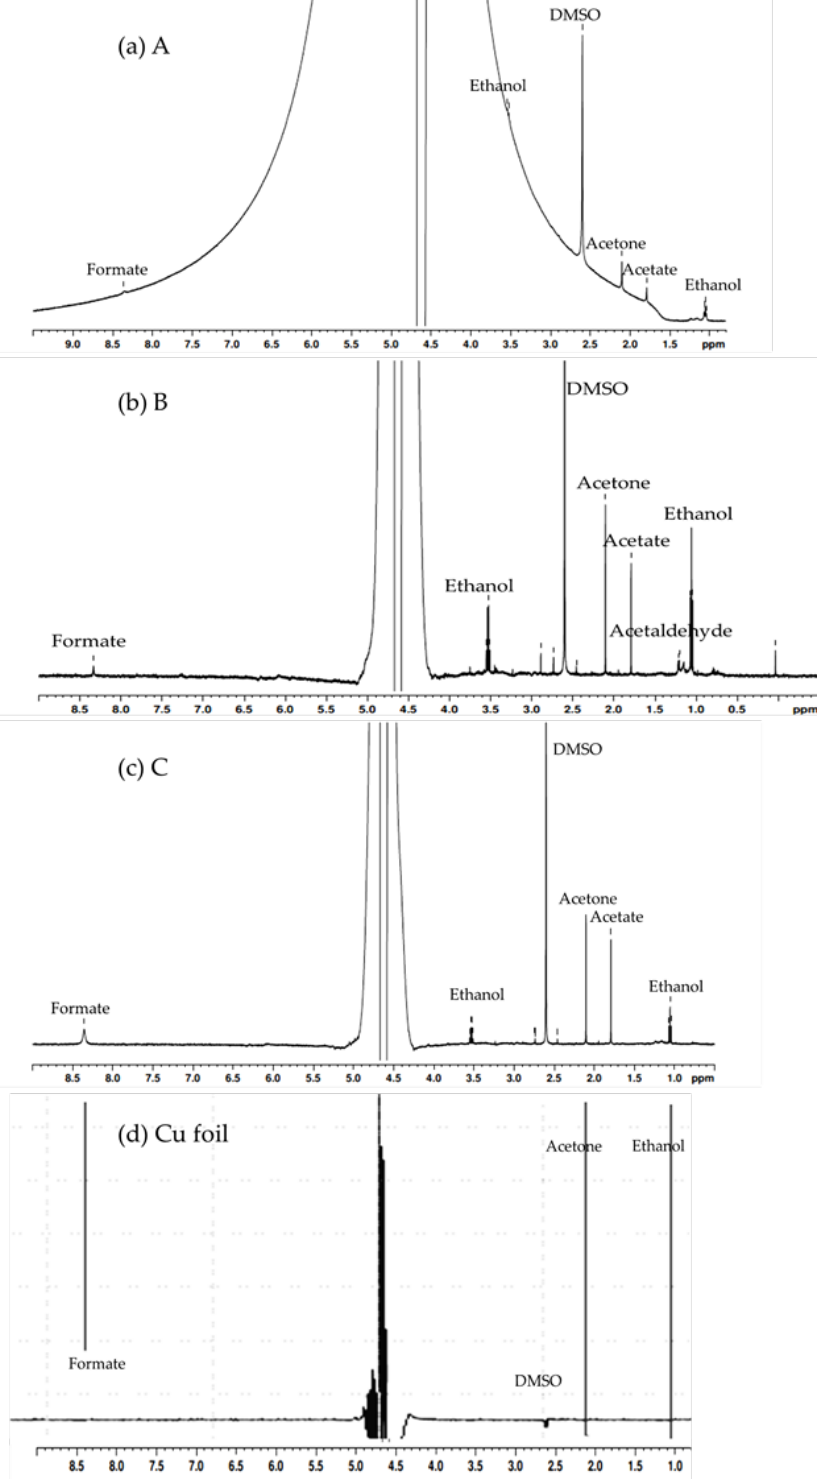
Figure 6. Representative NMR spectra obtained from the CO 2 RR experiments, using porous Cu samples from groups ( a ) A, ( b ) B, and ( c ) C, electrodeposited with 3 A/cm 2 for 40 s, and ( d ) the Cu foil as